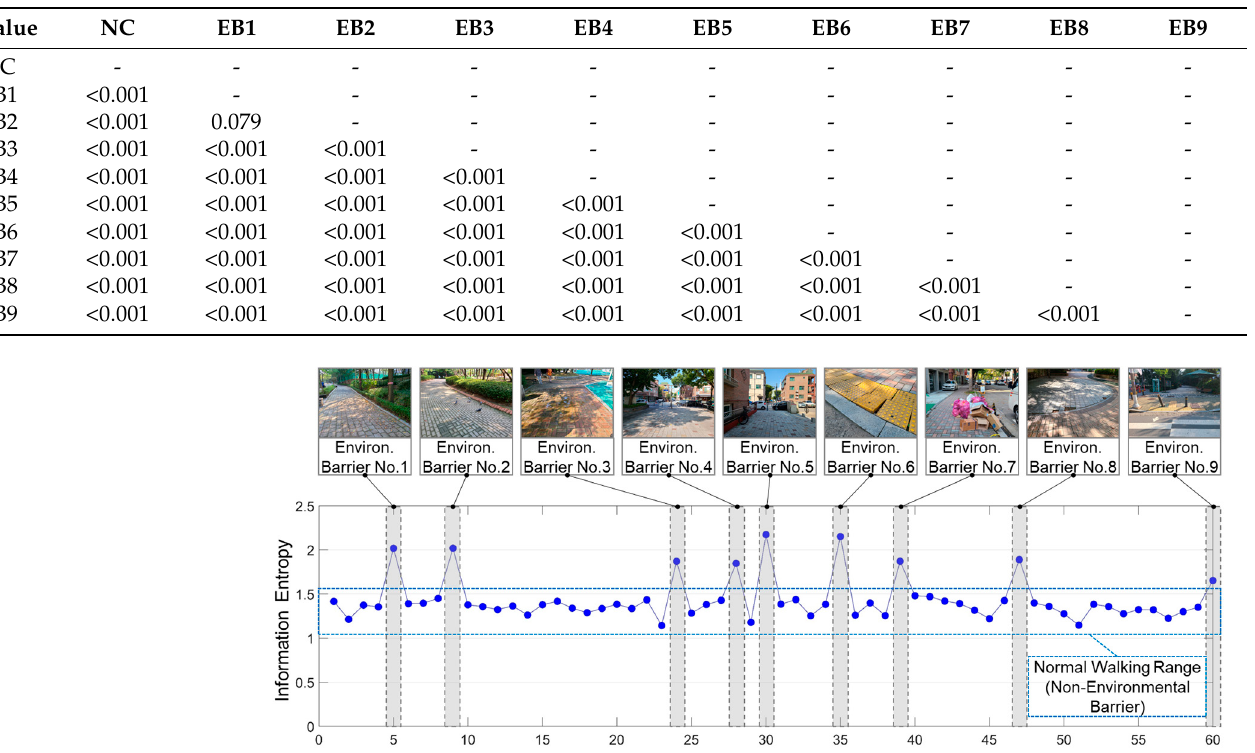
Table 4. t -test results of pairwise comparison among cells with/without an environmental barrier.